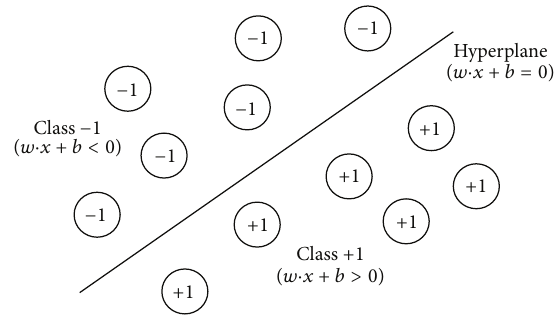
Figure1:Linearclassifierdefinedbythehyperplane 𝐻 (𝑤⋅𝑥+𝑏 = 0)